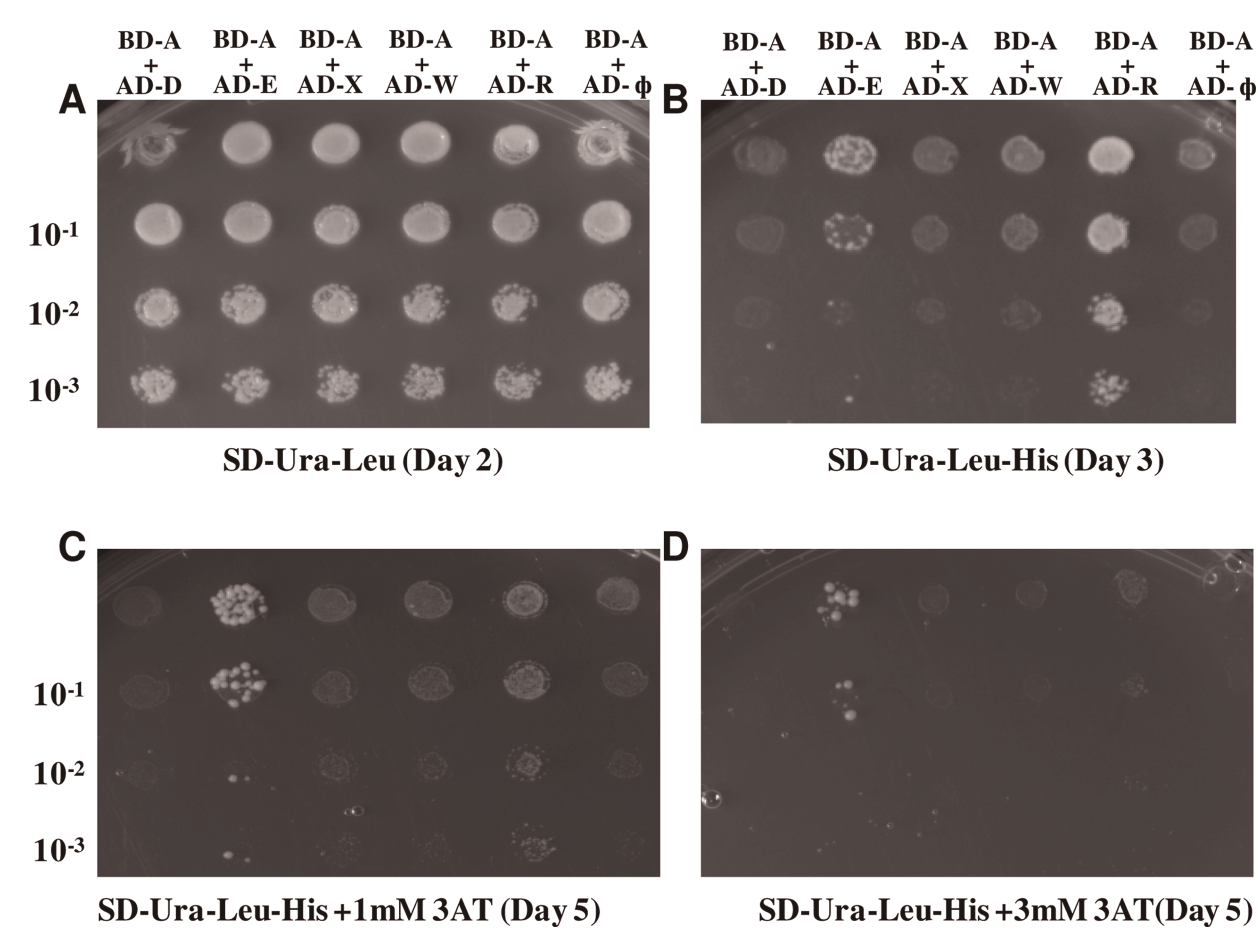
Figure 6. Screening of candidate DprA targets with yeast two-hybrid assay. Images were taken at indicated time during the incubation of the diploids (BD-A + AD-D, BD-A + AD-E, BD-A + AD-X, BD-A + AD-W, BD-A + AD-R, BD-A + AD- ) in four kinds of agar plates for five days: SD-Ura-Leu ( A ), SD- Ura-Leu-His ( B ), SD-Ura-Leu-His + 1 mM 3AT ( C ) and SD-Ura-Leu-His + 3 mM 3AT ( D ). AD, activating domain of pACT2 ; BD, DNA binding domain of pGBDCU2 ; A, dprA ; D, comD ; E, comE ; X, comX ; W, comW ; R, recA ; SD, synthetic defined medium; Ura, uracil; Leu, leucine; His, histidine; 3AT, 3-Amino- 1,2,4-triazole.